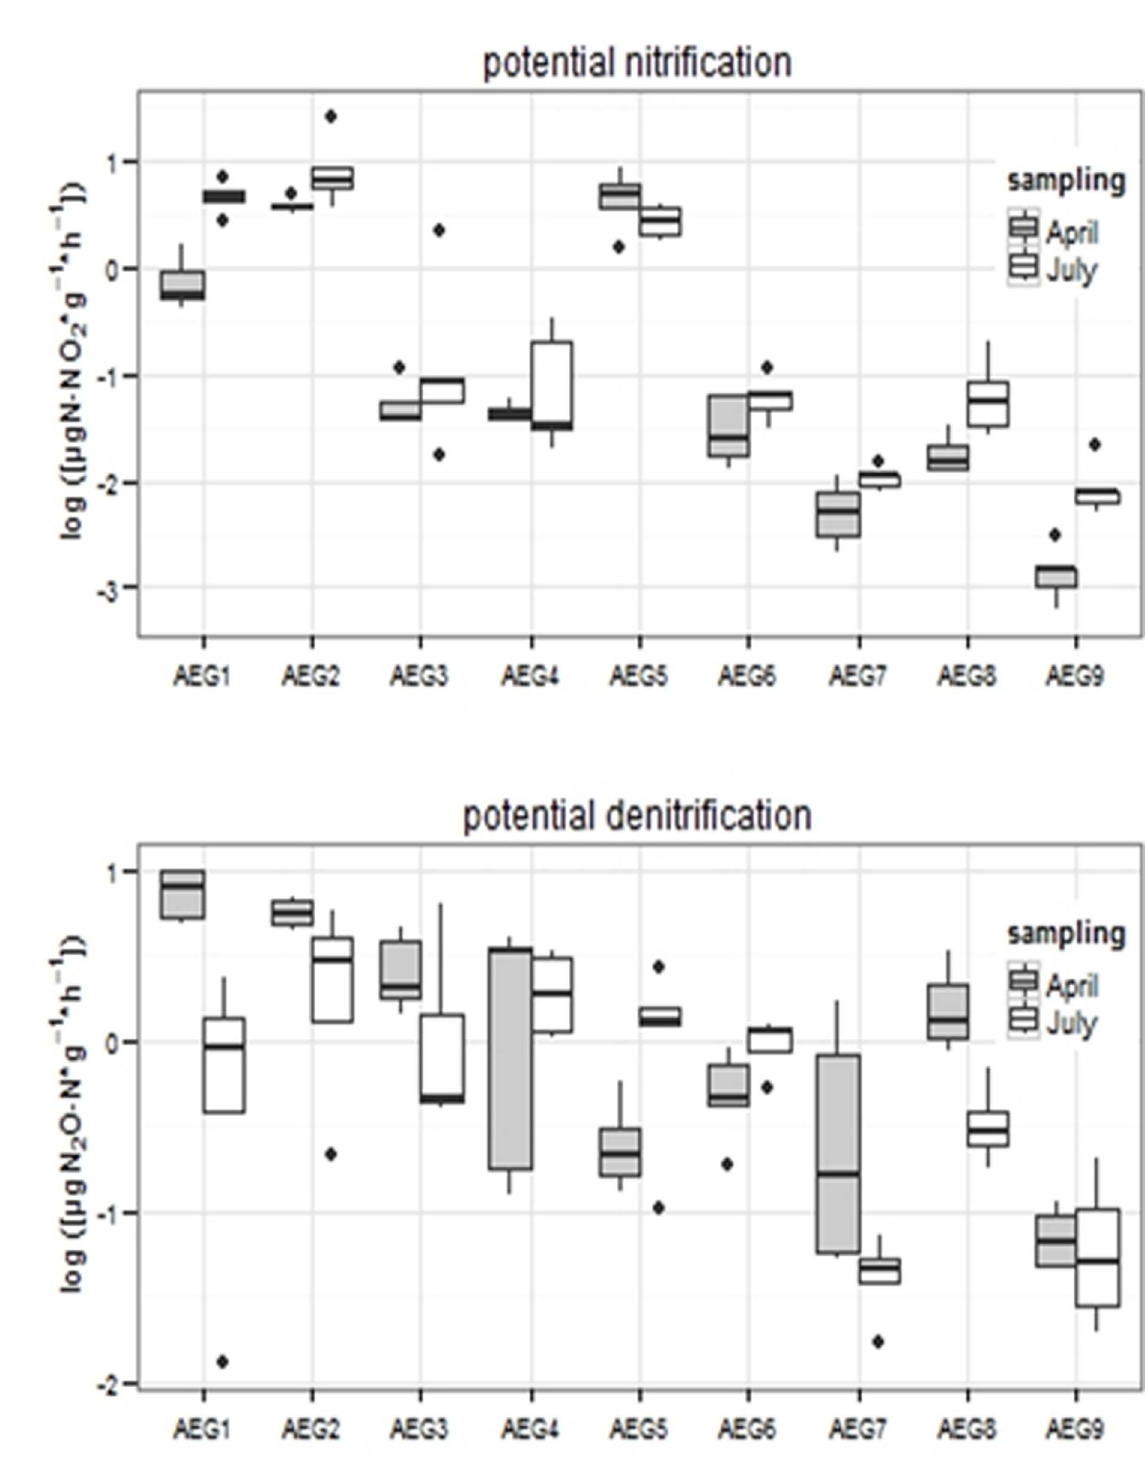
Figure 1. Box plot analysis of potential enzyme nitrification and denitrification activity at two different sampling time points (April and July) at 9 different grassland sites with different land use intensity. All data are log-transformed.